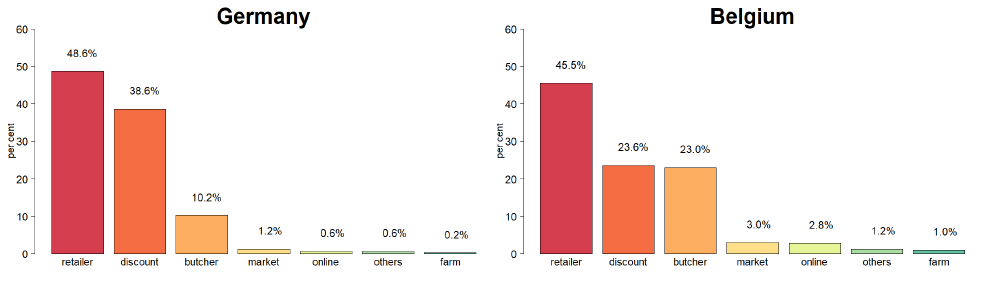
Figure 1. Preferred buying location of meat/meat products.